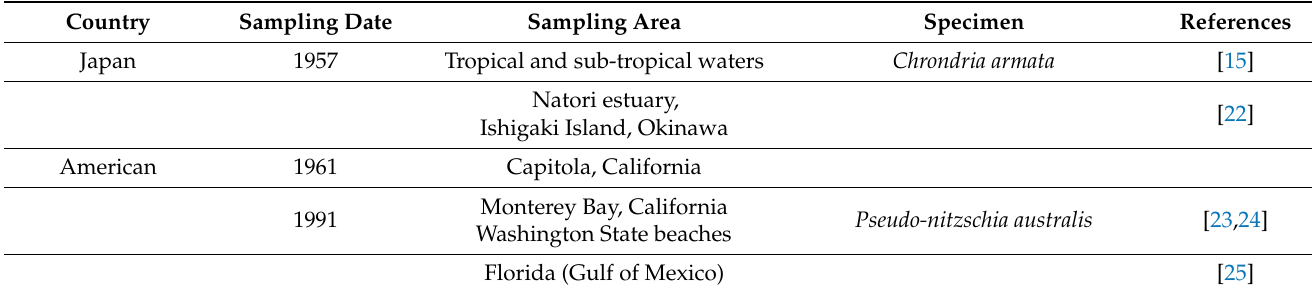
Table 1. Geographical distribution of domoic acid accord to the early